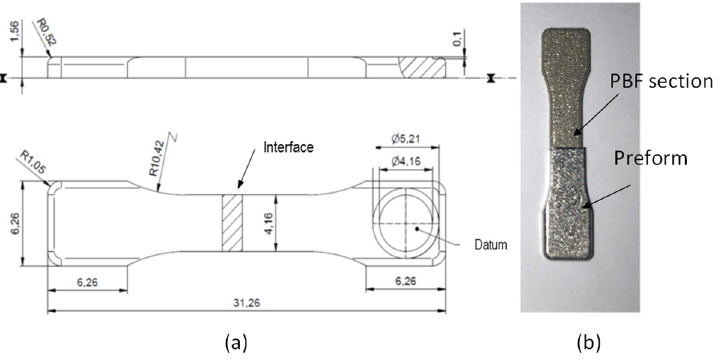
Figure 1. The test tensile bar. ( a ) Geometric dimensions [19]. ( b ) the produced hybrid MIM/L-PBF tensile